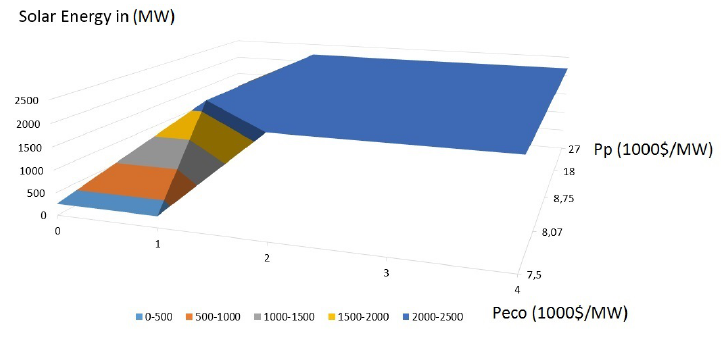
Figure 4. Variation of the optimal solar energy contract capacity with respect to P eco and P p in case of certainty (own